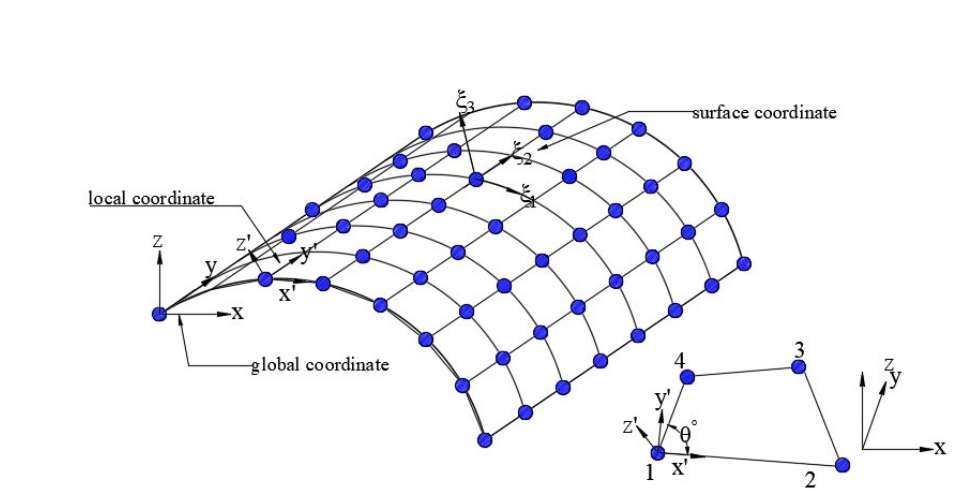
Figure 2: General shell discretised by quadrilateral elements with Local (primed), global (unprimed) and surface